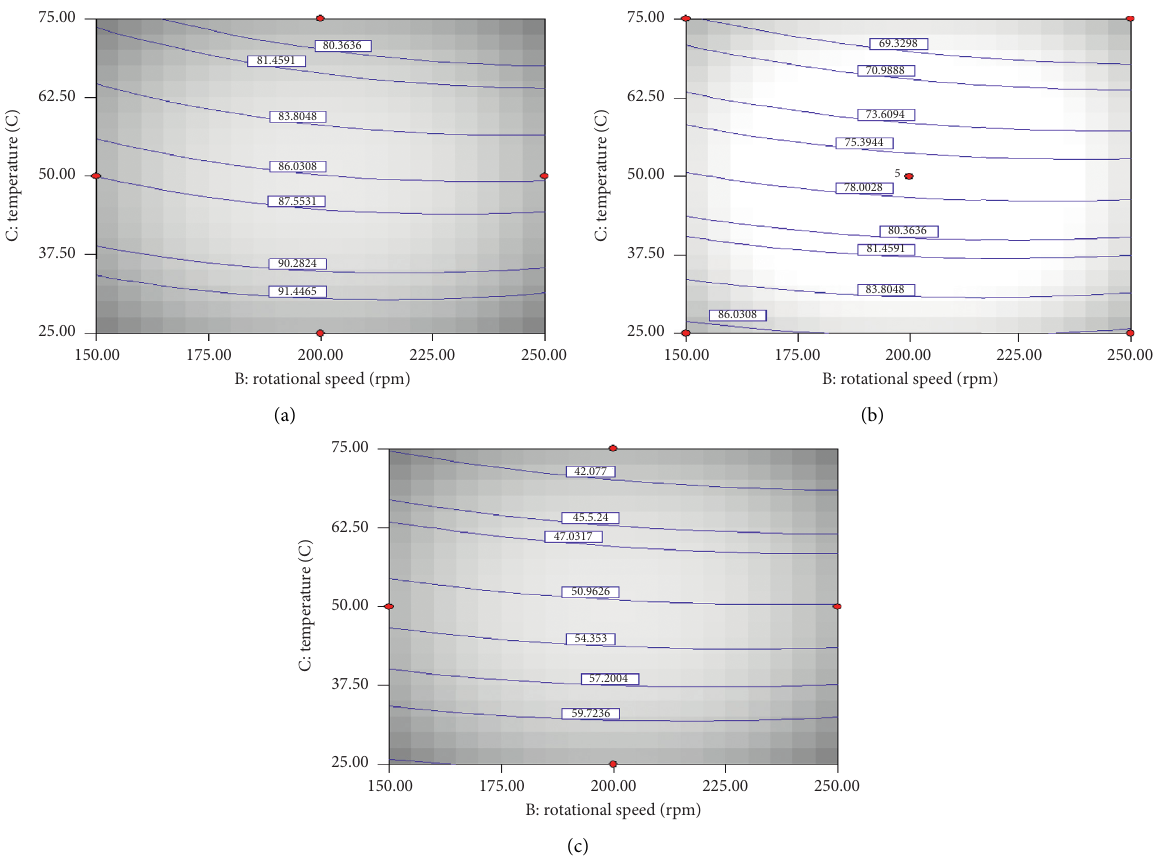
Figure 16: Contour plot of inhibition efficiency as a purpose of rotational speed and temperature at the inhibitor loads (a) 10%, (b) 7.5%, and (c) 5%.